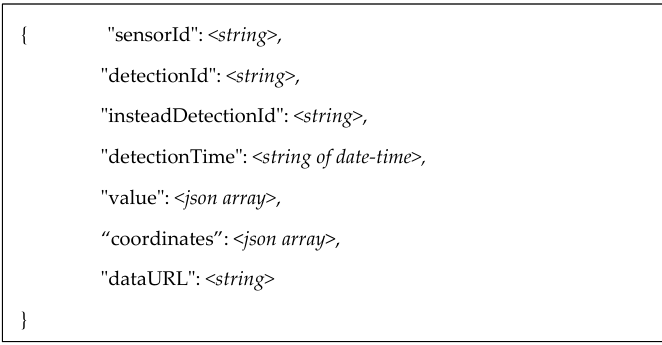
15 of 25 Figure 8. JSON message template for a generic sensor result . • “detectionTime” is a string representing the absolute time of the result of the sensor observation, and it follows the ISO 8601 combined date and time format. The Univer-